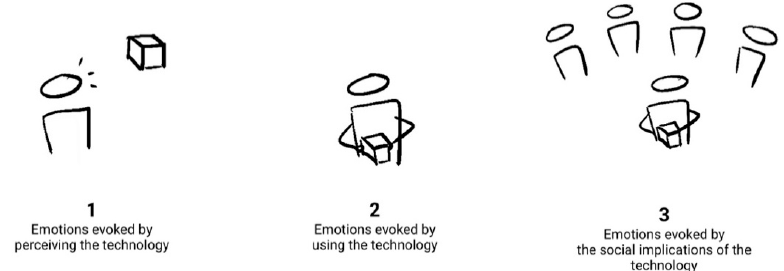
Figure 1. Three sources of emotions in human–product interactions (adapted from Desmet and Roeser